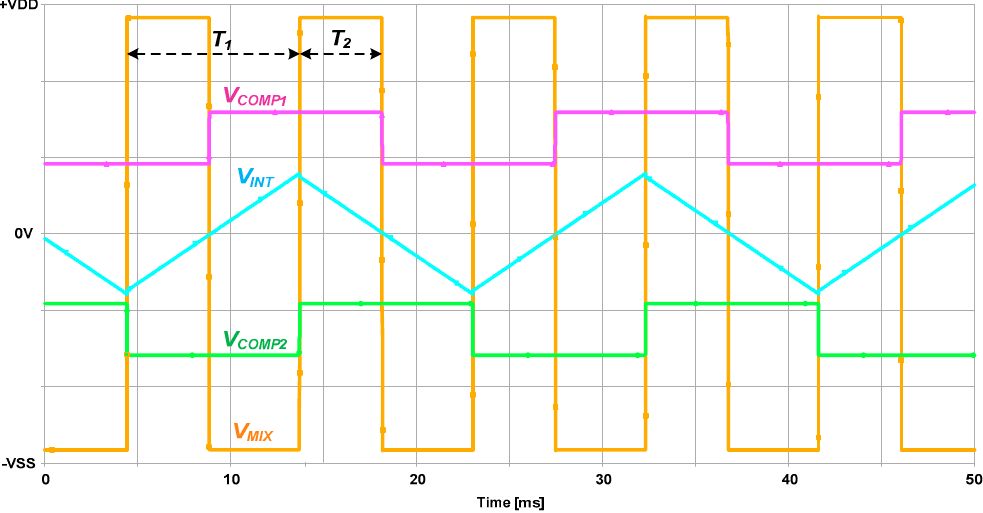
Figure 3. Example of the time response of the proposed interface evaluating the voltage signals at its main nodes.